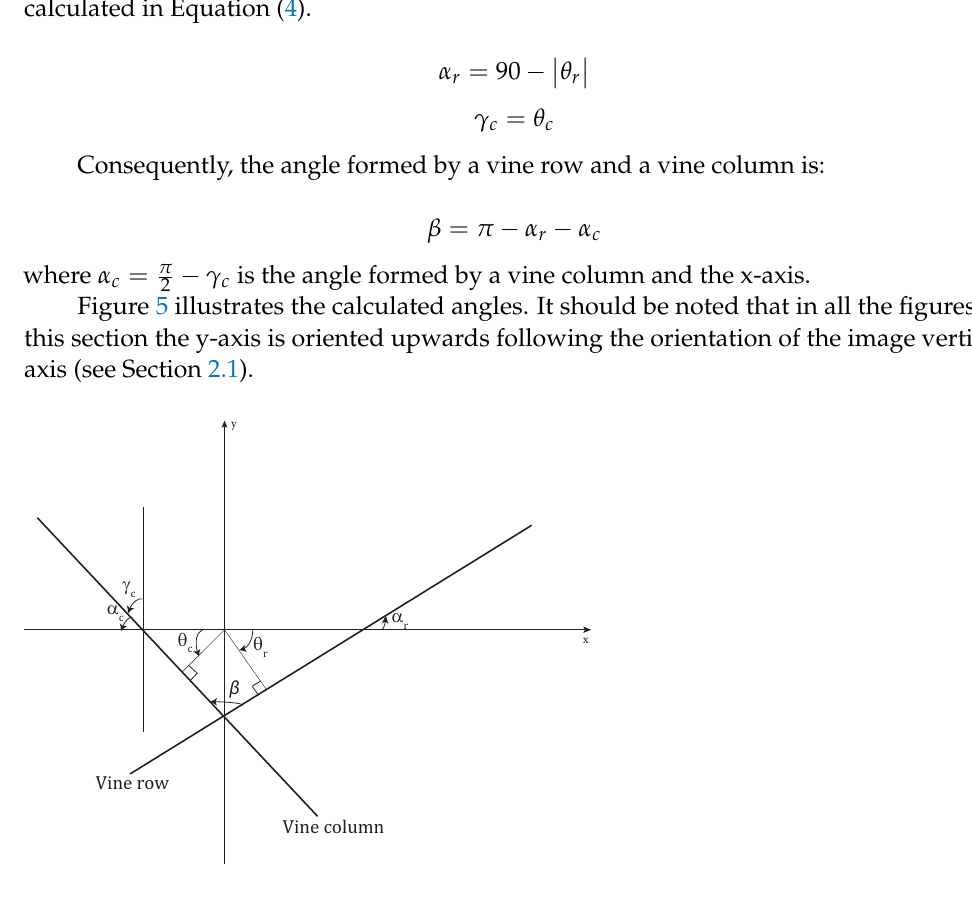
Figure 5. Grid rotation